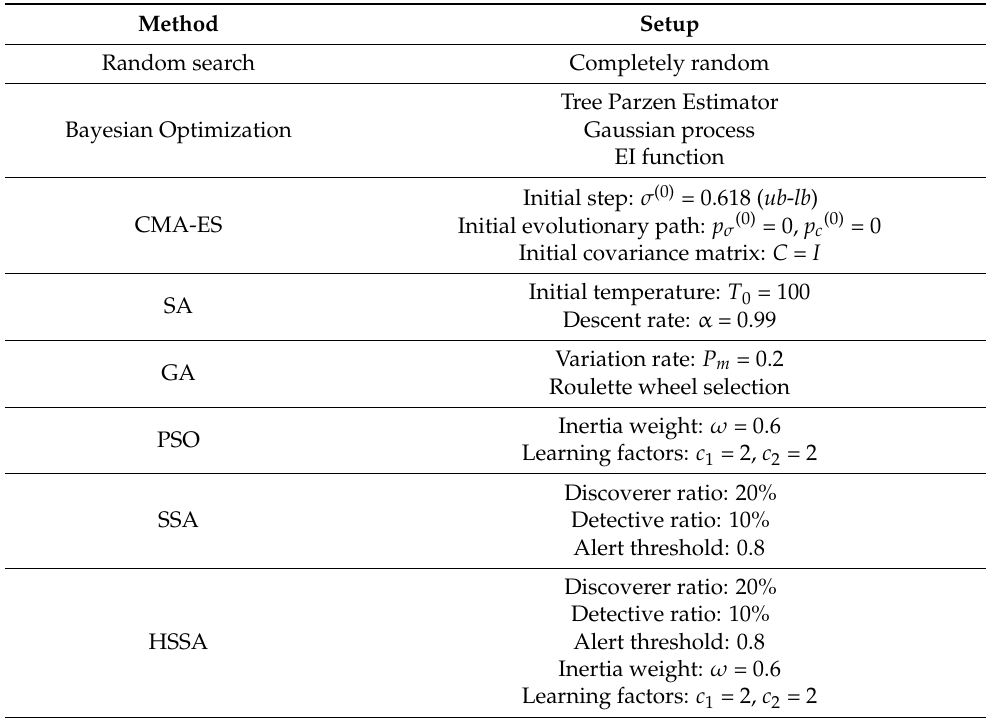
Table 1. Settings of all